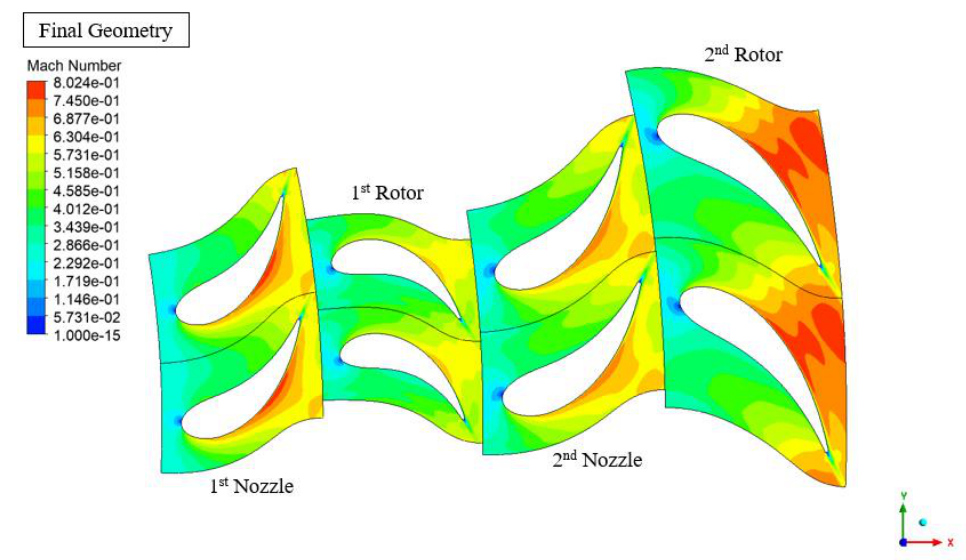
Figure 22. Mach number contour of the final geometry.